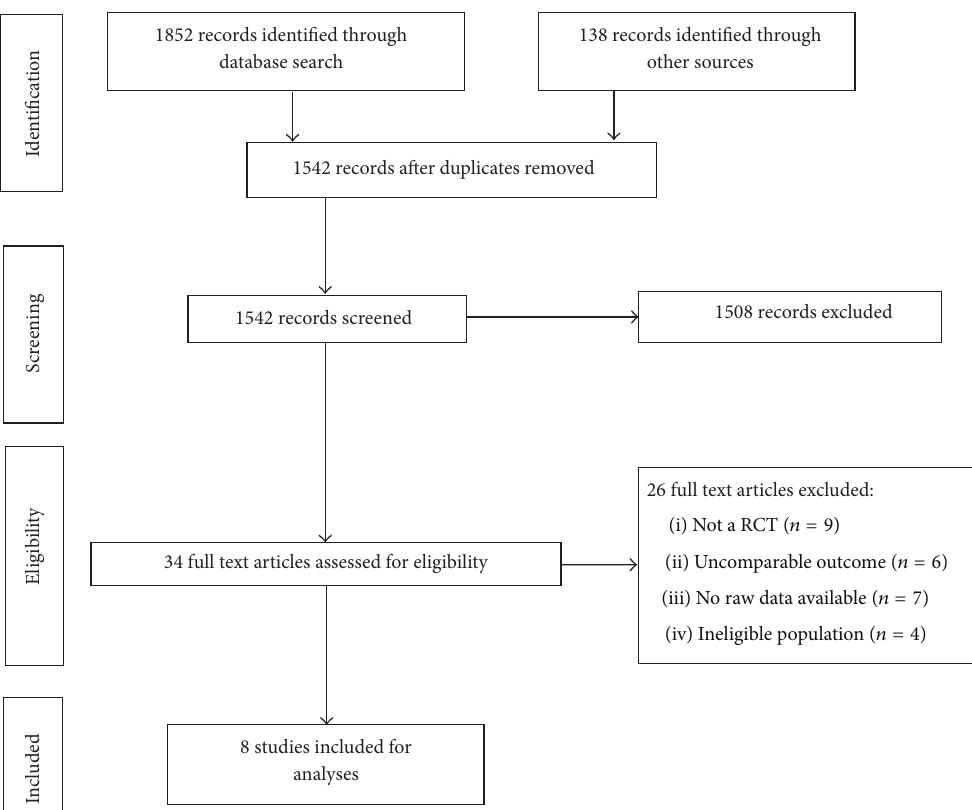
Figure 1: PRISMA Study Flow